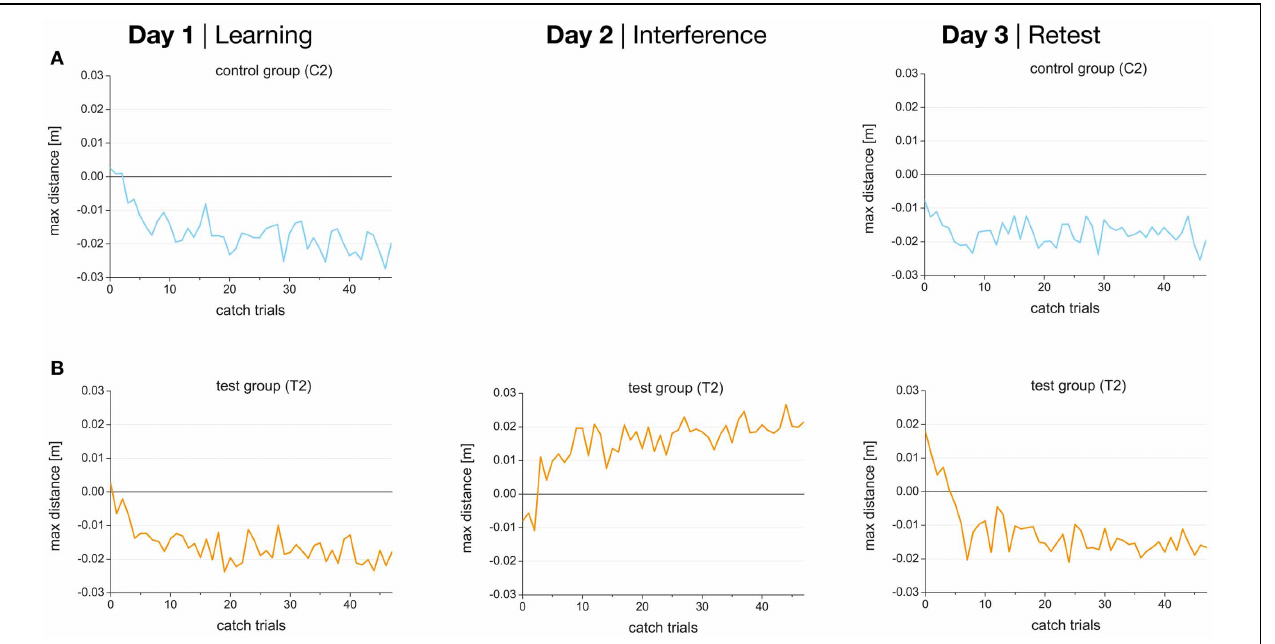
FIGURE 6 | Performance (maximum perpendicular distance) during 48 catch trials in force field A on day 1 (learning), force field B on day 2, and force field A on day 3 (retest) for control (A) and test